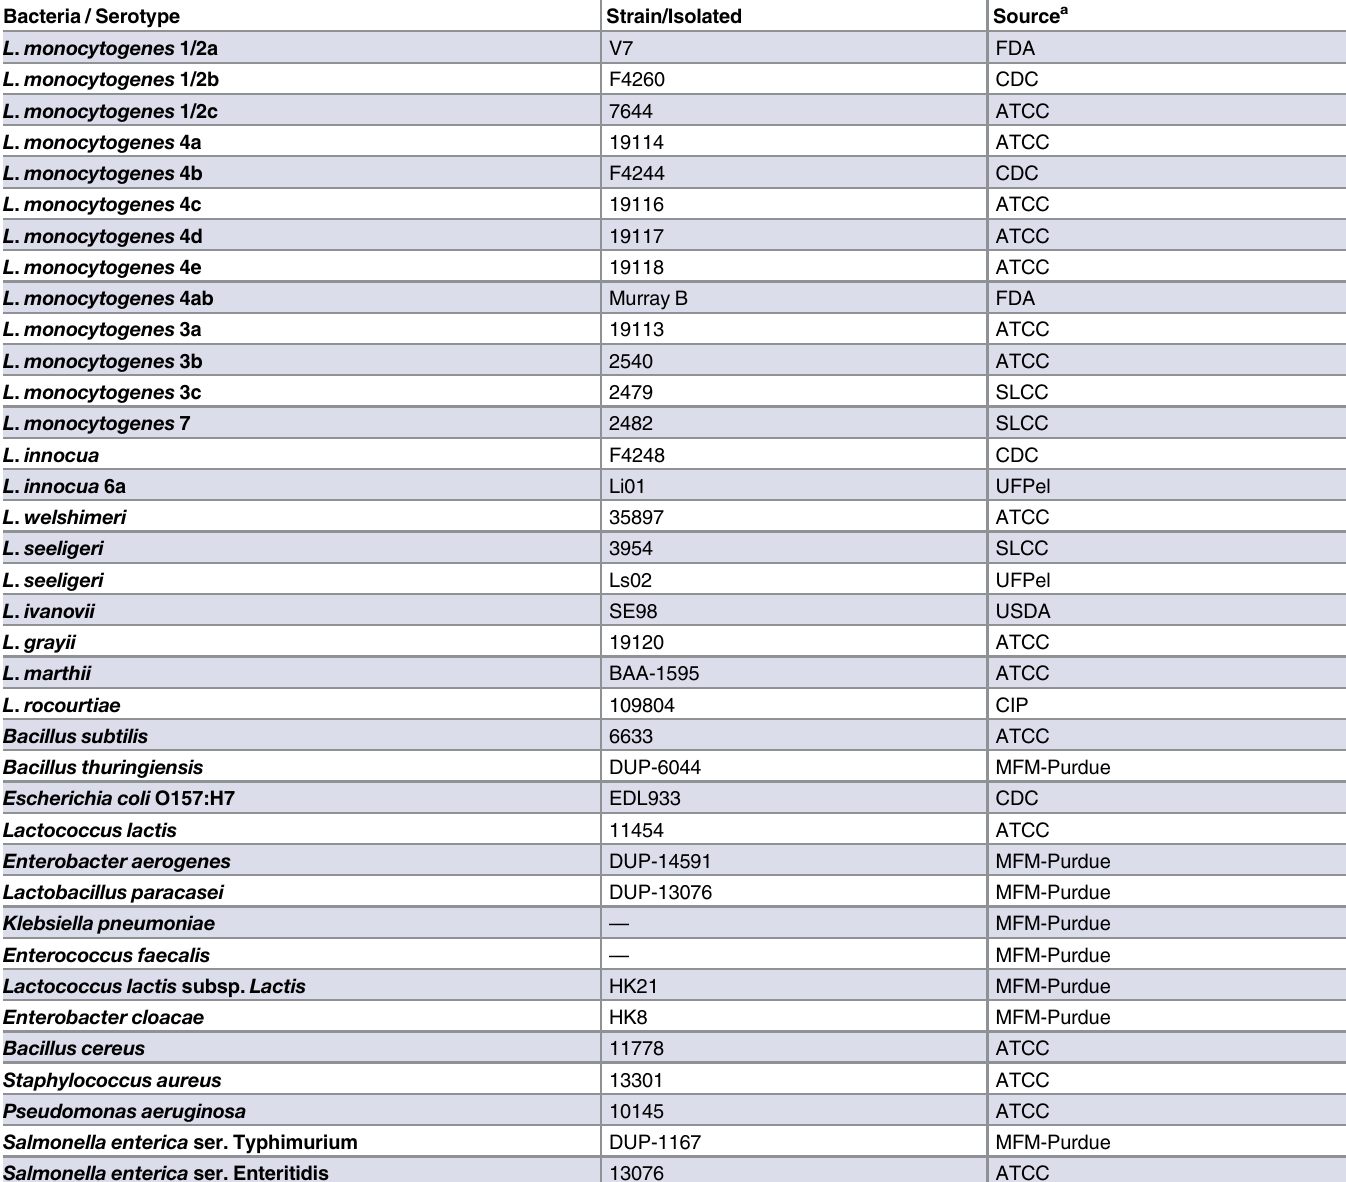
Table 1. Bacterial strains used in this